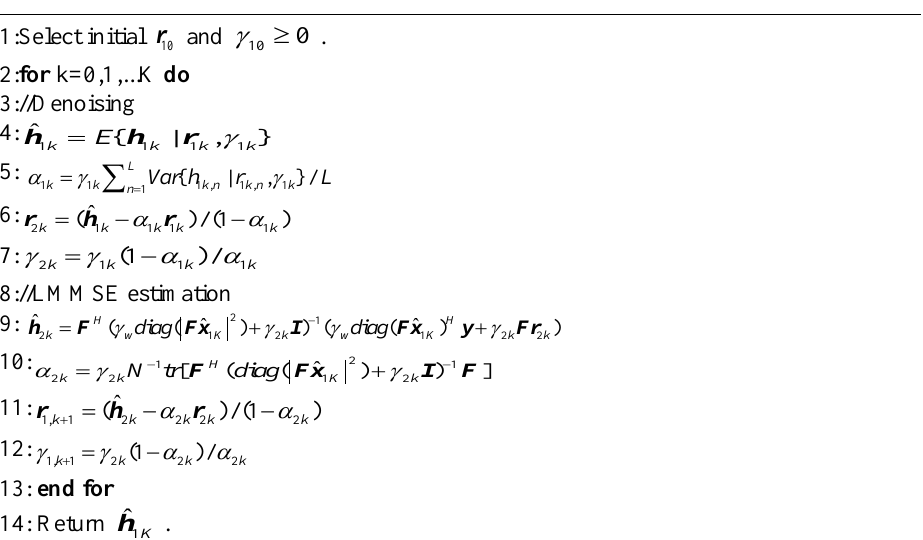
Algorithm 3 VAMP Channel Estimation Algorithm in SC-FDE